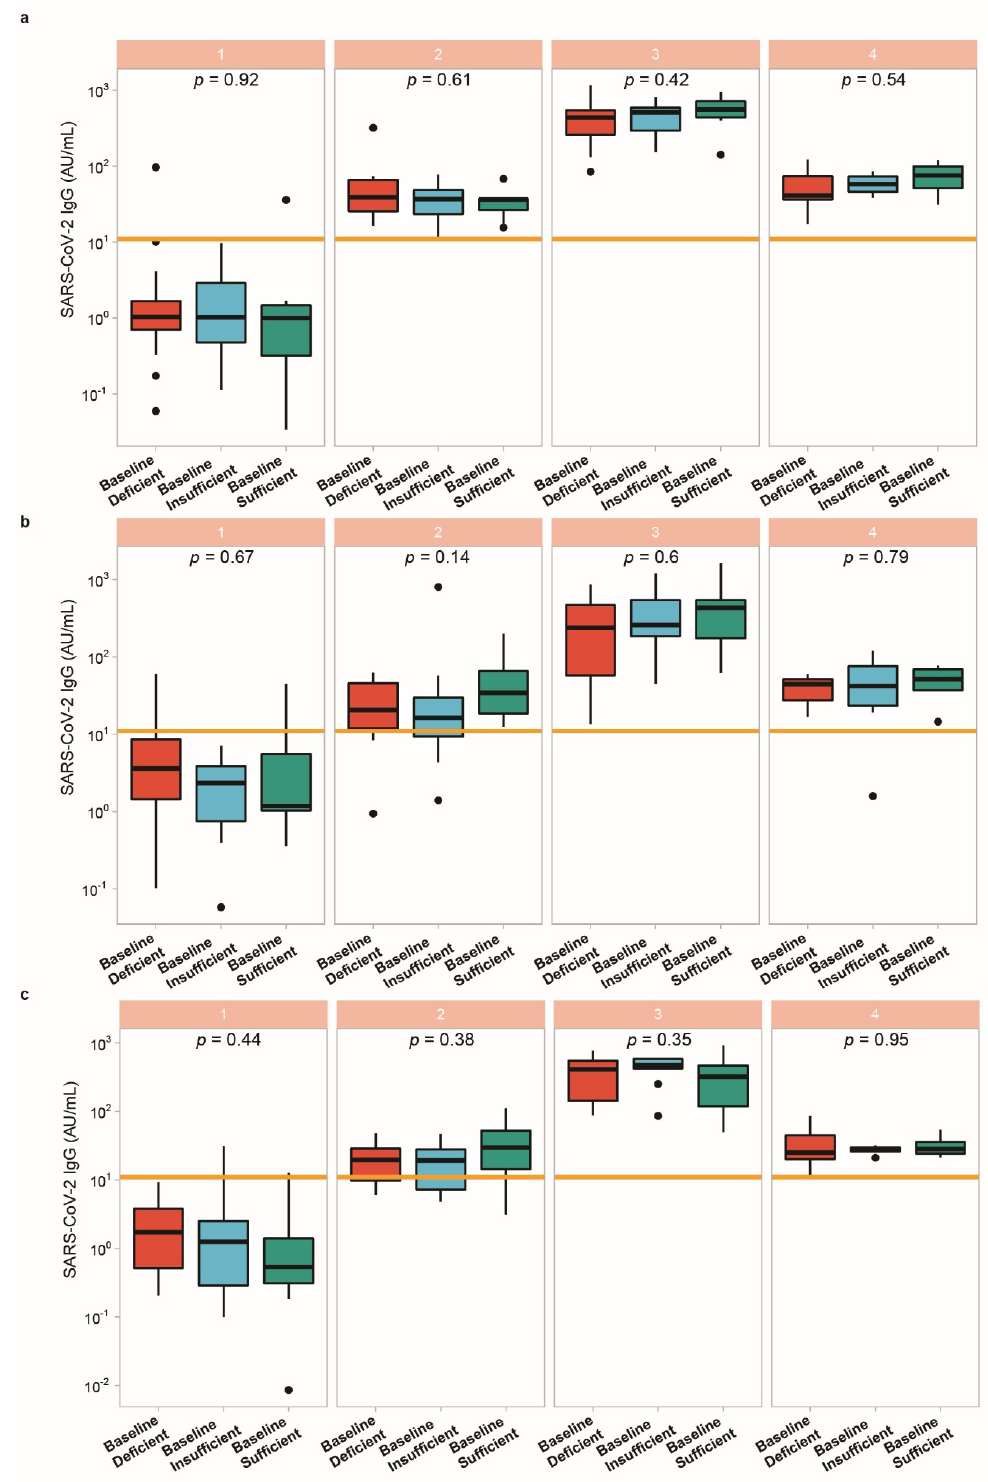
Figure A3. Vitamin D status in relation to SARS-CoV-2 IgG titres according to age tertiles. The cohort of samples was subdivided according to age of the participant into three separate age categories, i.e., ( a ), age < 40, ( b ), age < 53, and ( c ), age > 53 years. Baseline vitamin D status was not associated with antibody response in any of the three age groups. Kruskal-Wallis test was used for comparing the